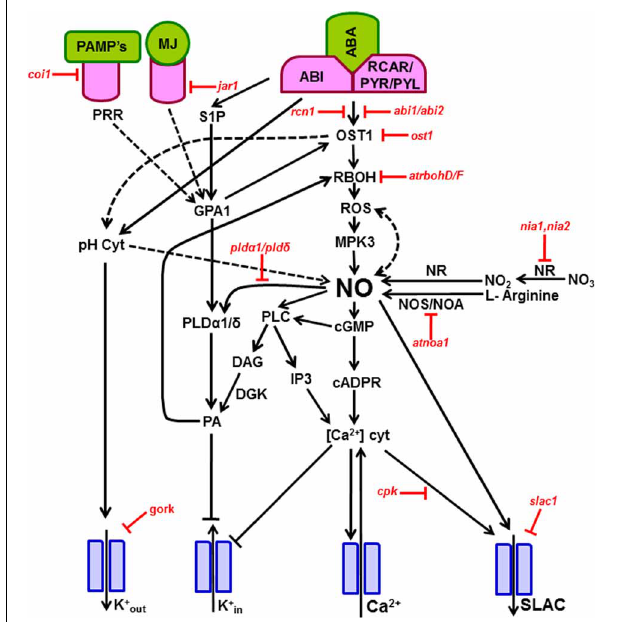
FIGURE 1 | Signal transduction mechanism involved during stomatal closure induced by ABA, MJ, and microbial elicitors. The components/secondary messengers induced by either ABA or MJ or elicitors leading to the production of nitric oxide are indicated by forward arrows. The ion channels are represented by blue color. During stomatal signaling mechanism the guard cells upon perception of ABA, MJ, or elicitors, activate NADPH oxidase, leading to a burst of ROS, which leads to a NO burst. The elevation of NO raises the cytosolic free Ca 2 + , through up-regulation of cADPR and cGMP. In turn, the high cytosolic Ca 2 + causes a down-regulation of K + inward channels and activation of outward anion channels, all leading to stomatal closure. Parallely, NO can increase the levels of PA via modulation of PLD and PLC. Several of these steps are validated by the use of mutants of Arabidopsis (indicated by red color), deficient in a particular signaling component. In the mutants, the relevant steps are blocked. The Arabidopsis mutants represented in this Figure are: abi1/abi2 , ABA-insensitive (ABI1 and ABI2 protein phosphatases); atrbohD/F , A. thaliana NADPH oxidase catalytic subunit D/F; atnoa , A. thaliana nitric oxide-associated 1; coi1 , coronatine-insensitive 1 mutant; cpk , calcium-dependent protein kinase; gork , guard cell outward rectifying K + channel; jar1 , JA response 1 mutant; nia1, nia2 , Nitrate reductase double mutant; ost1 , open stomata 1 kinase; pld α 1/pld δ , phospholipase α 1/phospholipase δ double mutant; rcn1 , protein phosphatase 2A regulatory A subunit 1; slac1 , slow anion channel-associated 1 mutant. A description of these components is given in the section on “Signaling components in guard cells during NO action.” Further information can be seen in Tables 1 , 2 . Abbreviations are listed in first page. The events demonstrated by experimental evidence are represented by solid arrows. The possible interactions/effects are indicated by broken arrows.